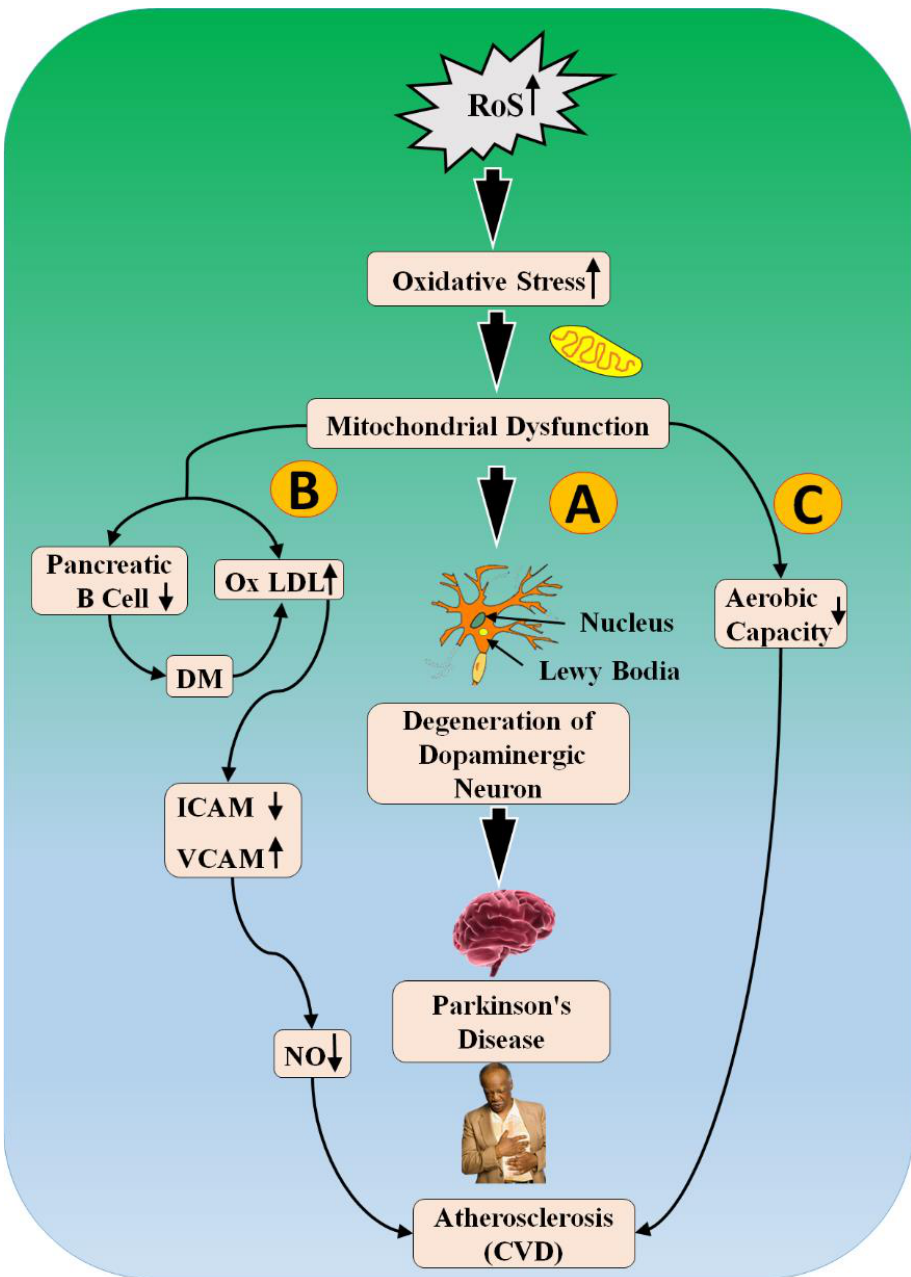
Figure 6. The biological link between PD and CVD. RoS: reactive oxides stress, ICAM: intercellular adhesion molecule, VCAM: vascular cell adhesion molecule, DM: Diabetes mellitus, NO: nitric oxide, OxLDL: oxidation of low-density lipoprotein; Up Arrow: depicts increase; Down Arrow: depicts decrease.